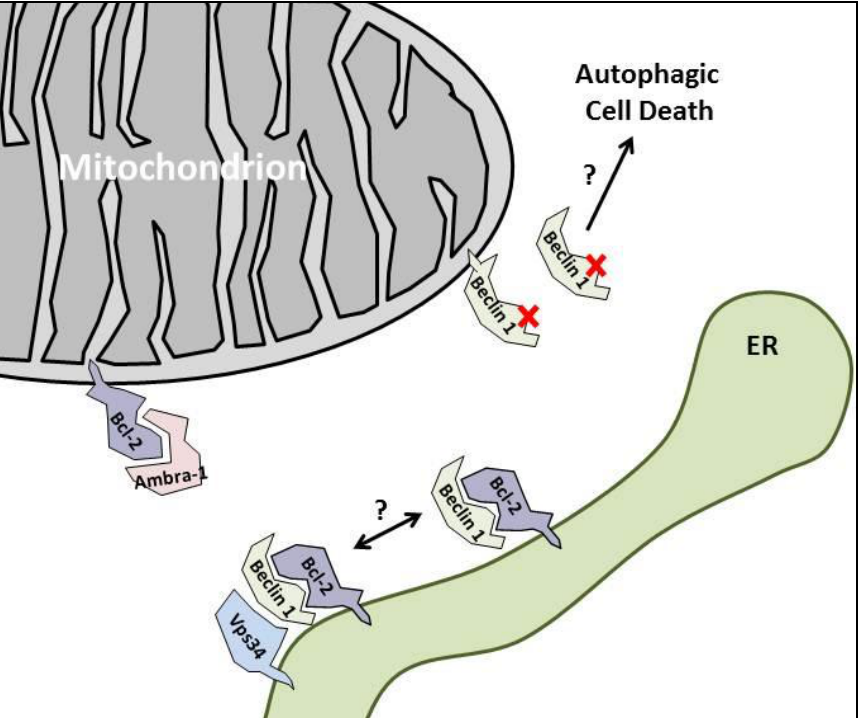
Figure 1. Bcl-2 tethers Beclin 1 at the ER. Representation of mitochondria, ER and the proteins of interest in normal growth conditions. Since only ER-Bcl-2 regulates autophagy, it is able to recruit Beclin 1 at the ER. Bcl-2-binding mutants of Beclin 1 (indicated with a red cross), therefore are less able to interact with Vps34 at the ER and fail to induce autophagy or could induce autophagic cell death. Whether Bcl-2/Beclin 1 complexes are devoid of Vps34 is still unclear. Beclin 1 can also associate with mitochondria. Ambra-1 binds mitochondrial Bcl-2 and prevents it from binding to Beclin 1. See text for detailed